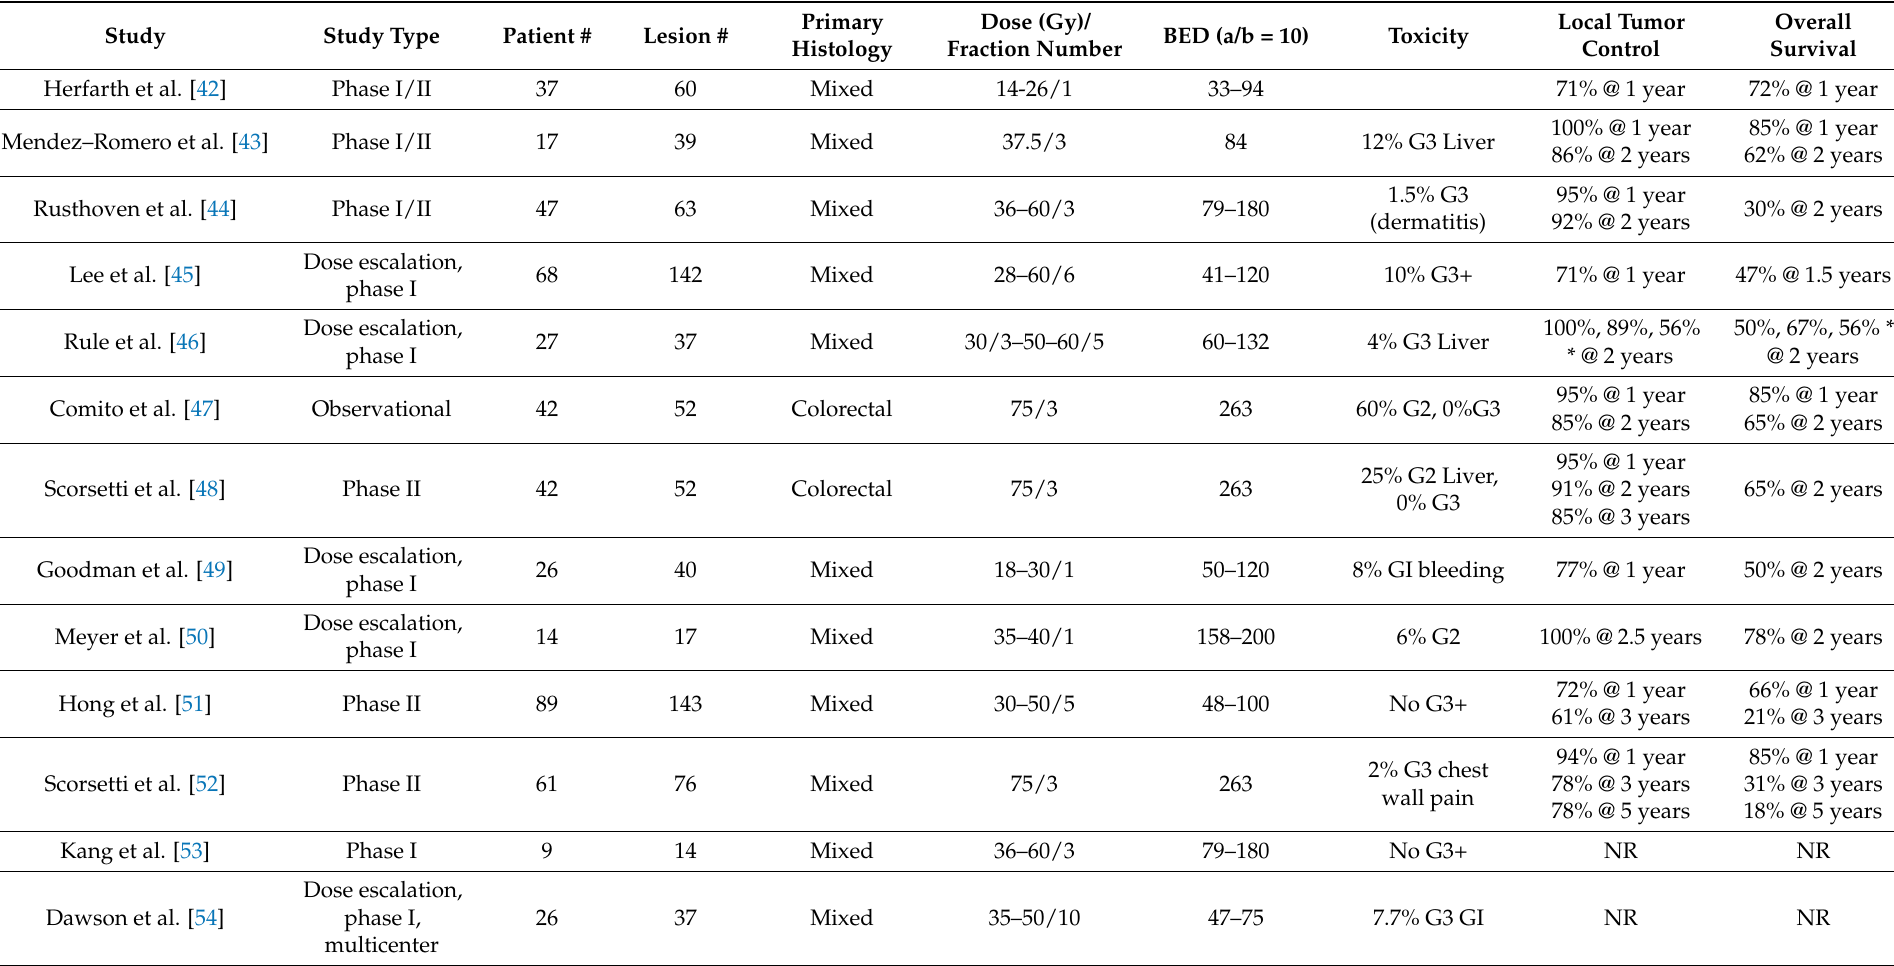
Table 1. Liver SABR prospective